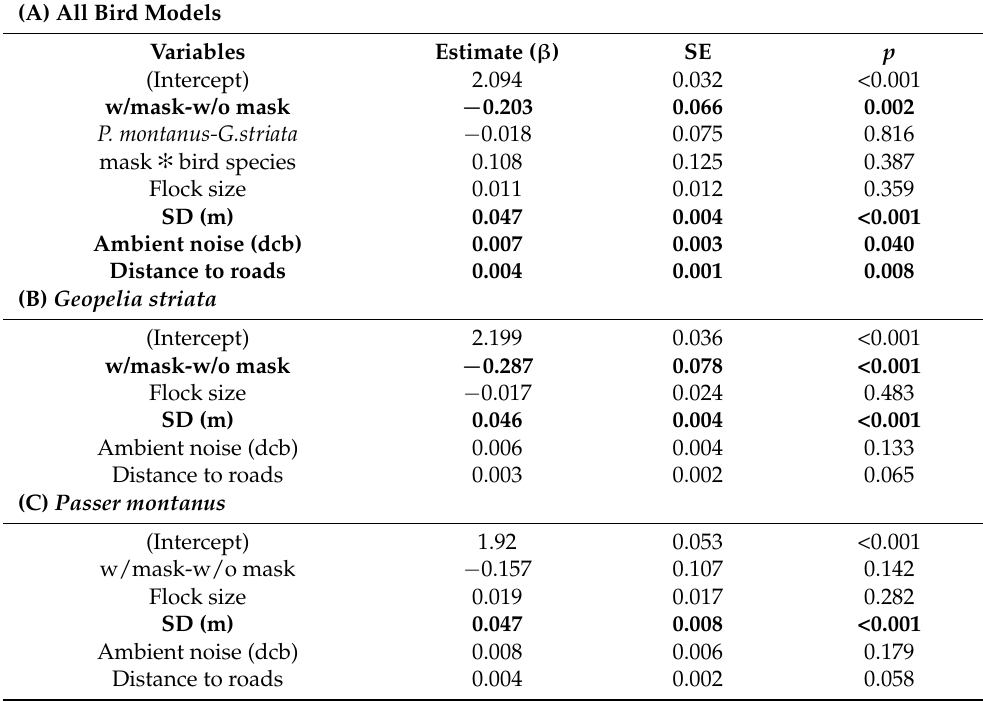
Table 1. Results of the generalized linear model (GLM) to determine the relationship between bird FID of all species (A), G. striata (B), and P. montanus (C) to mask wearing, species traits, and urbanization variables. The variables in bold indicate significance.